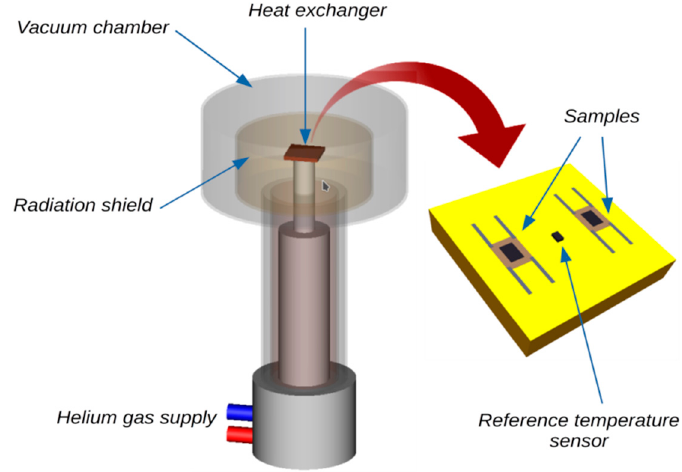
Figure 4. Cryogenic cooling system.